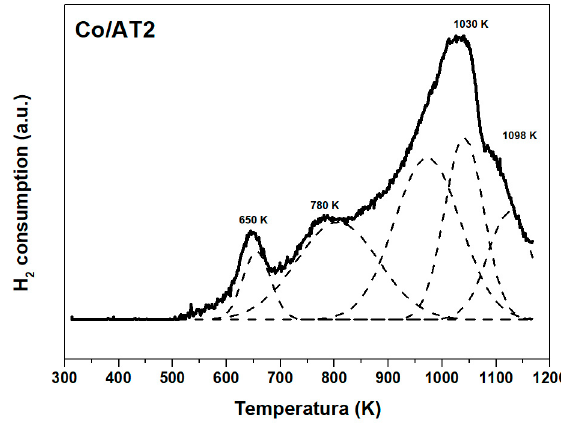
Figure 11. TPR profile of Co / AT2 catalyst calcined at 673 K.